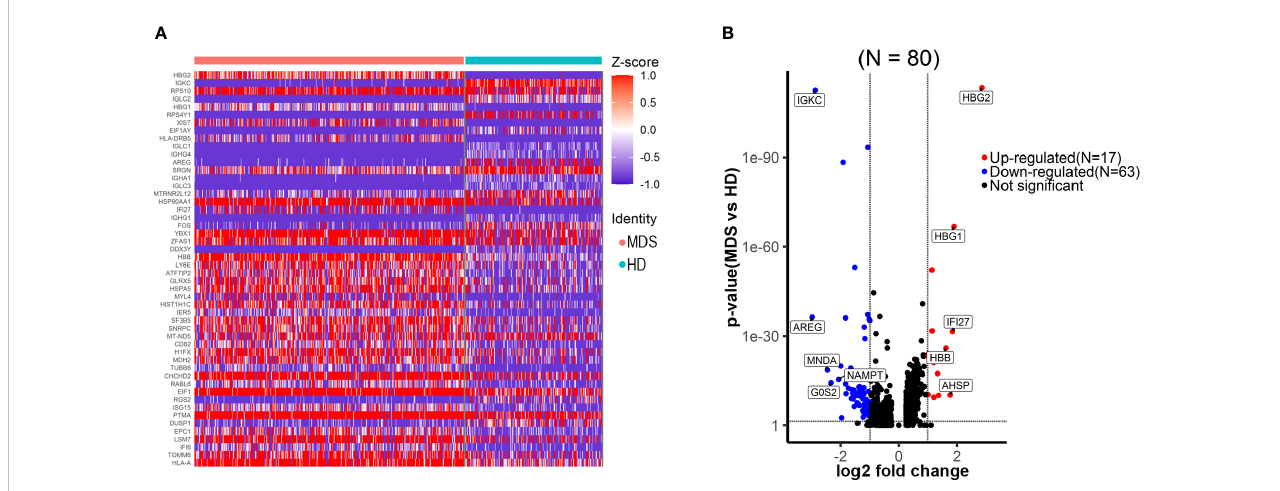
FIGURE 3 Transcriptional changes of the HSPC/CMP population in the tMDS patient identi fi ed with scRNA-seq. (A) Heatmap of the top 50 signi fi cantly differentially expressed genes between t-MDS versus HD HSPC/CMP populations, highlighting the distribution of transcript expression within the clusters. (B) Volcano plot revealing signi fi cantly differentially expressed genes between t-MDS versus HD HSPC/CMP populations (FDR ≤ 0.05 and log2 fold change ≥ 1.0, ≤ -1.0).